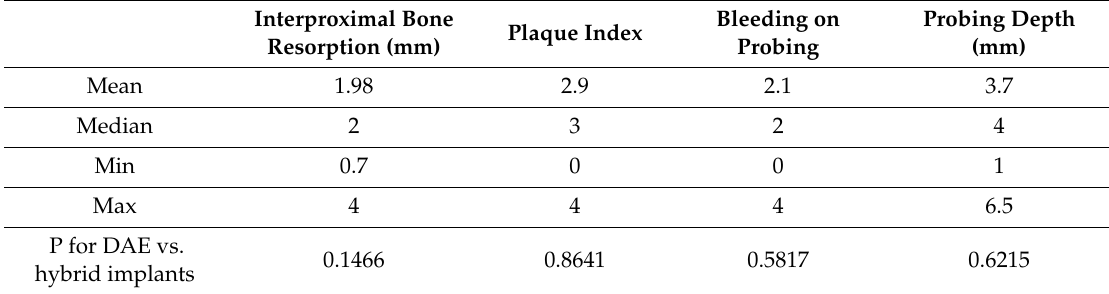
Table 1. Bone level and peri-implant health parameters recorded at the five-year follow-up appointment.